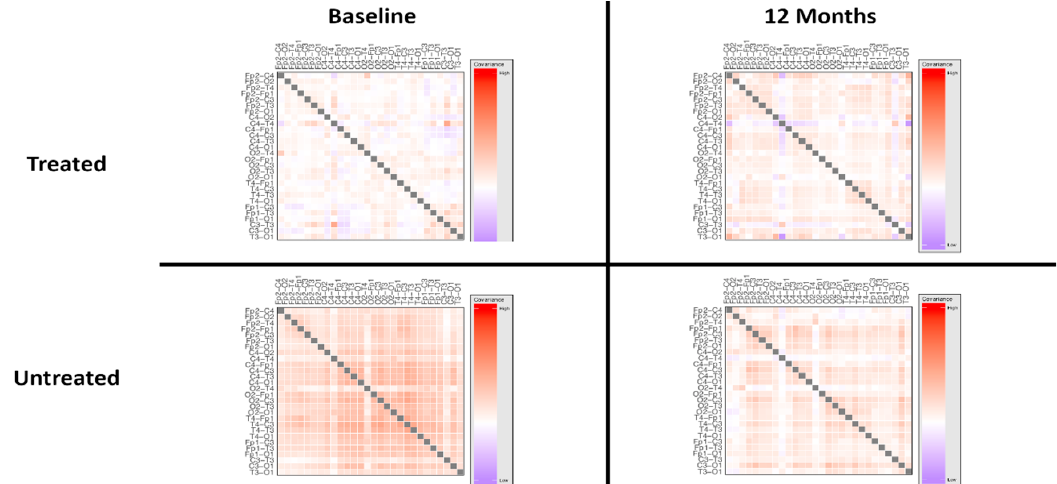
Figure 3. Schematic of network architecture at baseline and at twelve months, treated vs. untreated groups. ANOVA of network loadings (principal components of network measures) demonstrated statistically significant interaction between treatment status and time. There was no statistically significant effect of time alone. Detailed visualisations of network measures are shown in Figures Supplementary Materials.